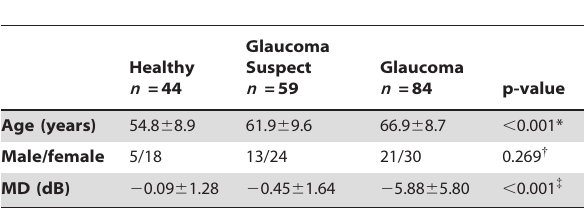
Table 2. Characteristics of the study